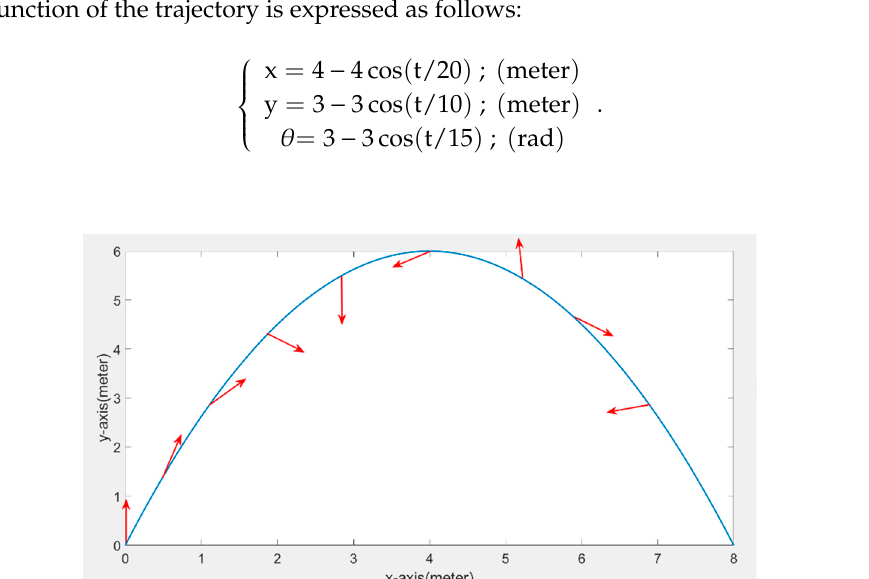
Figure 9. Cosine-functional curvilinear path.